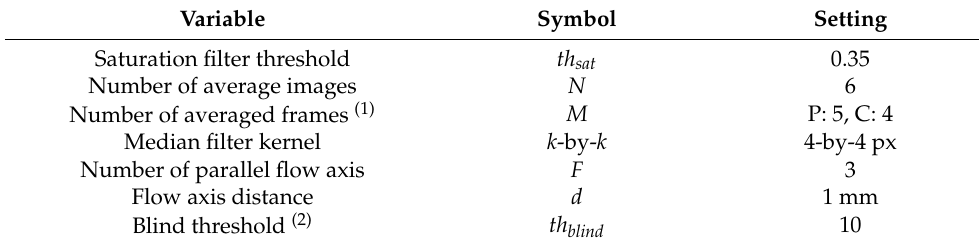
Table 4. Variables setting for blind angle parameter estimation.